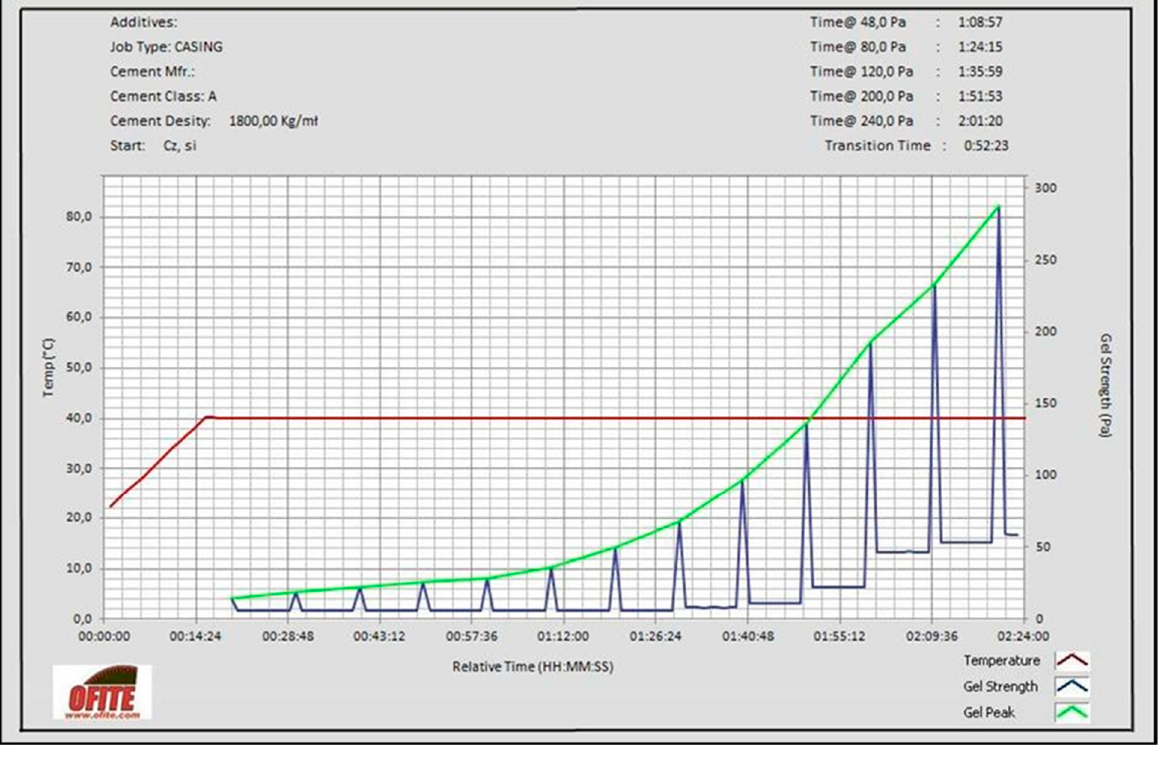
Figure 10. Static structural strength build-up for slurry with high anti-migration resistance.